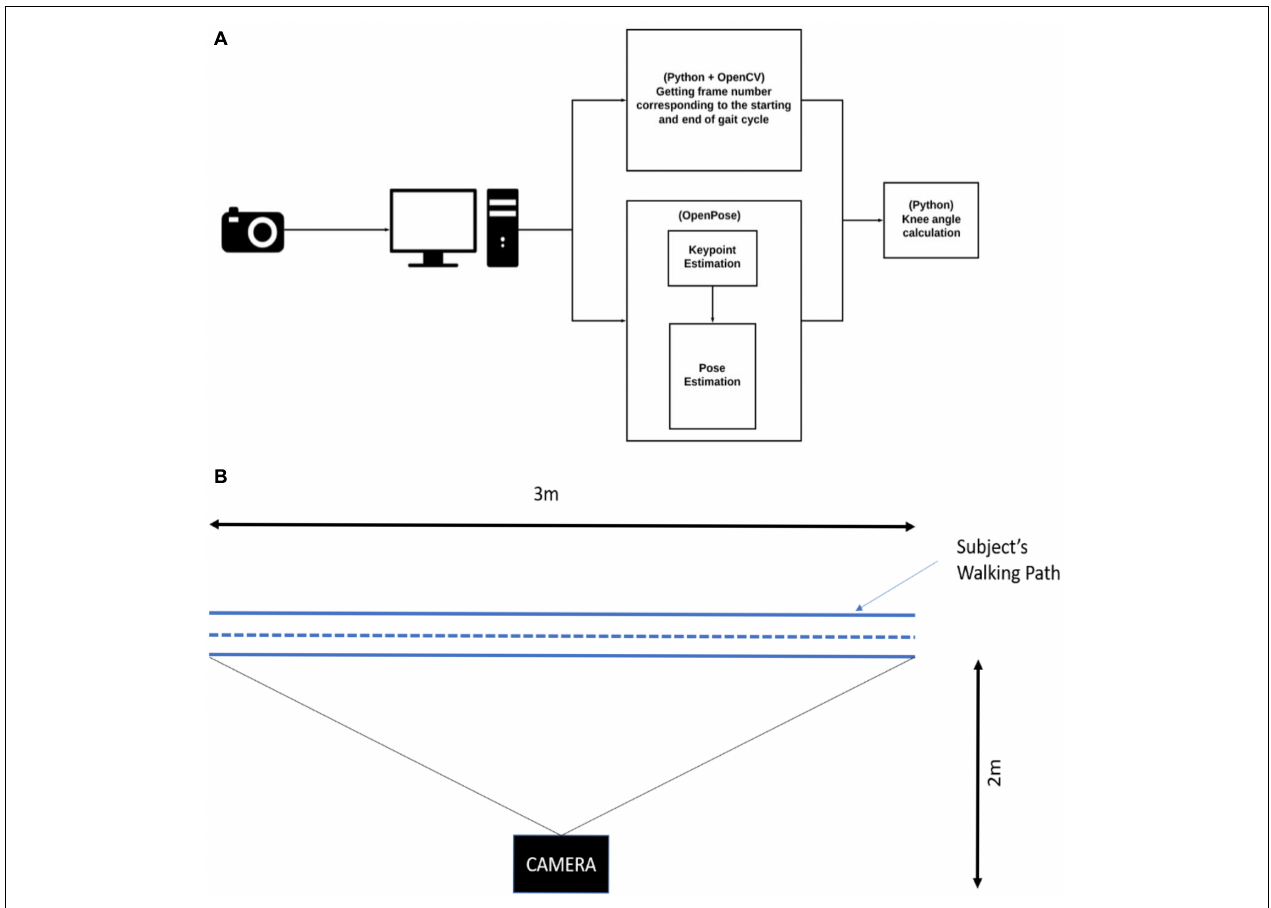
FIGURE 1 | (A) Schematic of the complete proposed simple system to measure kinematics of the gait, (B) location of the camera with respect to the subject walkway.